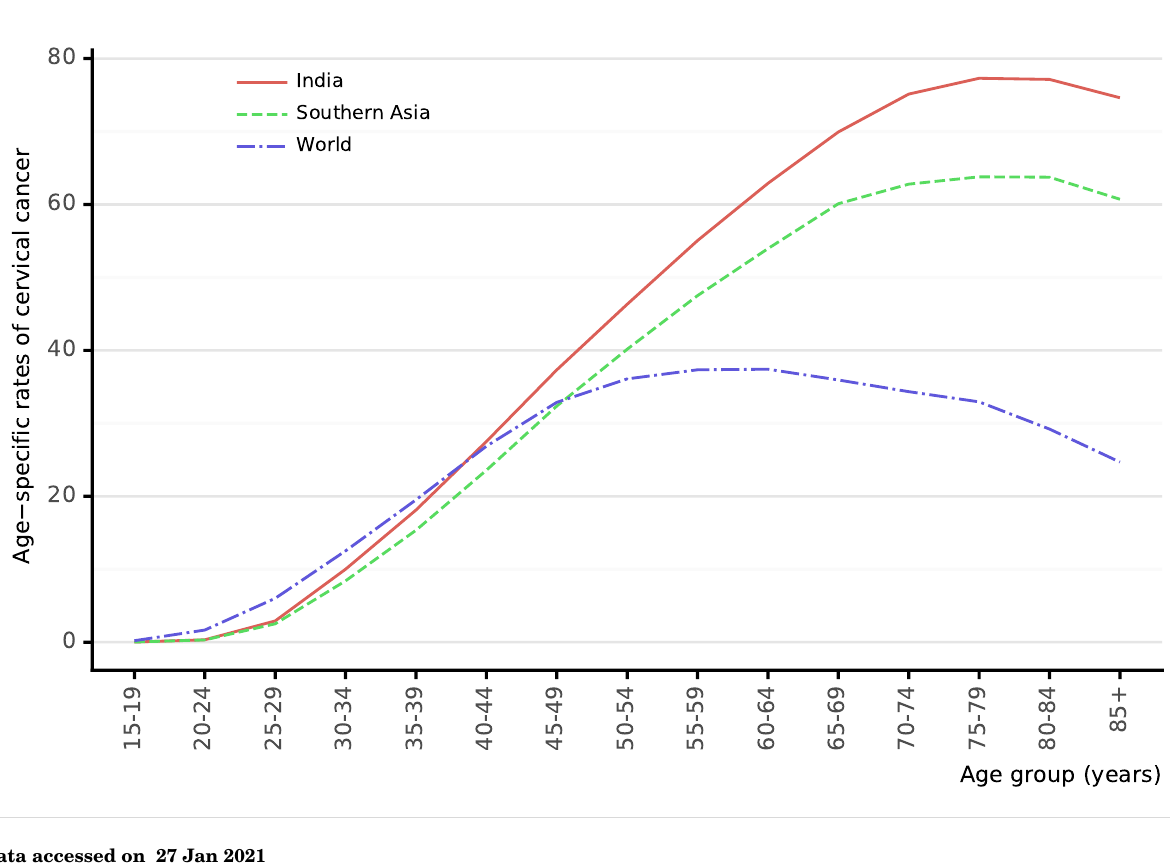
Figure 75: Comparison of age-specific cervical cancer incidence rates in India, within the region, and the rest of